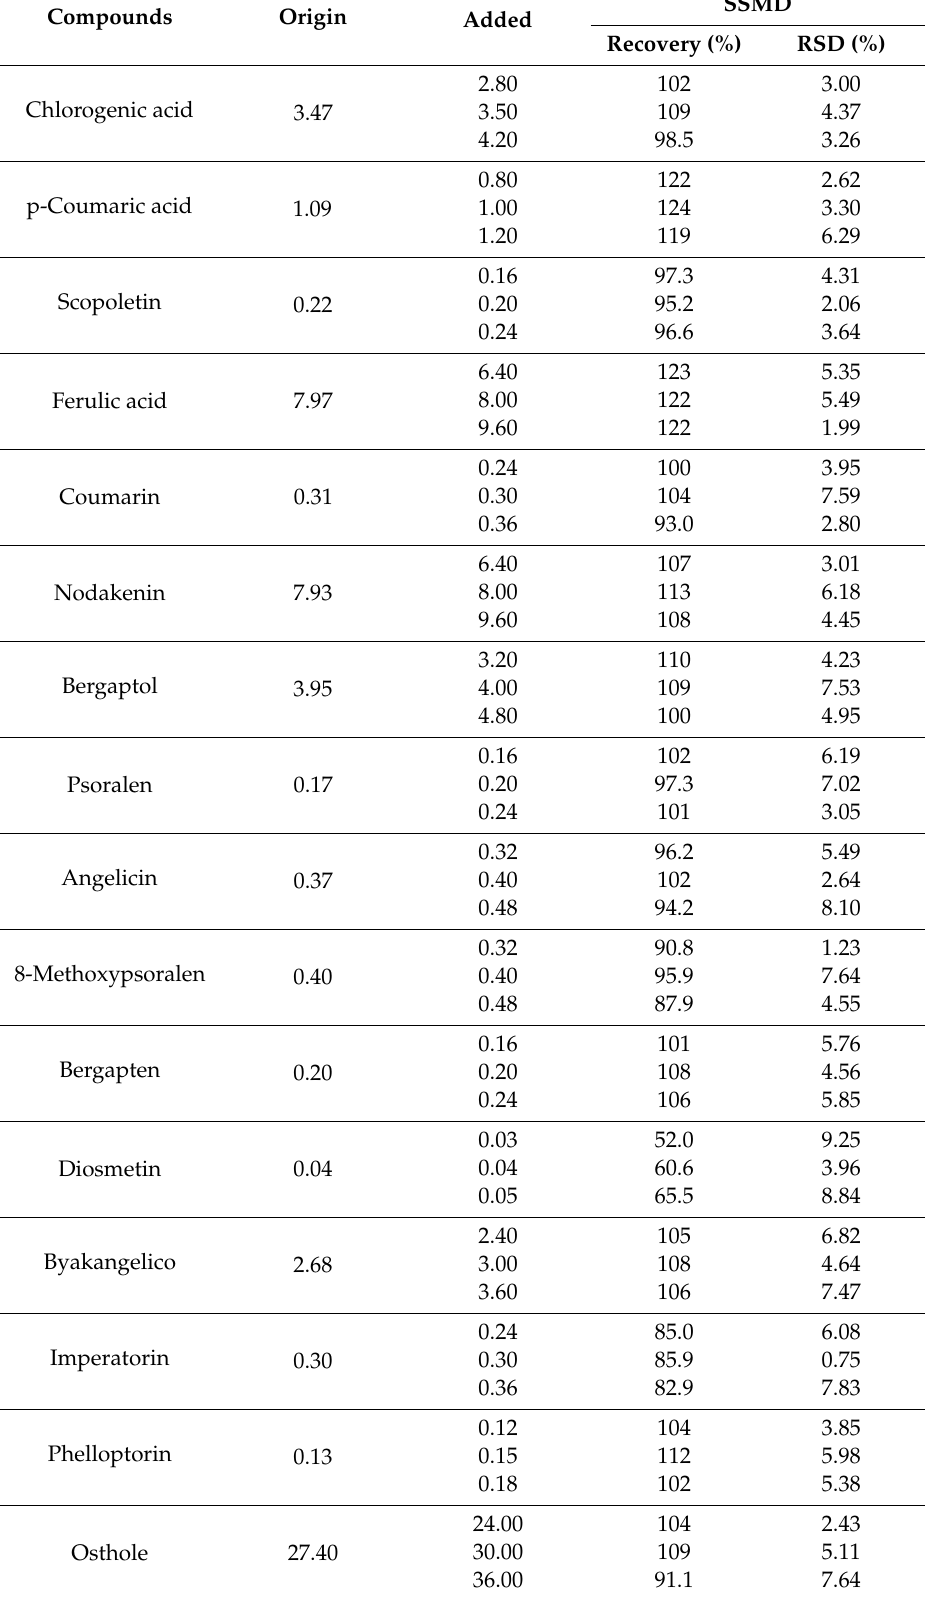
Table 4. Recovery of 19 compounds using the SSMD method ( n =